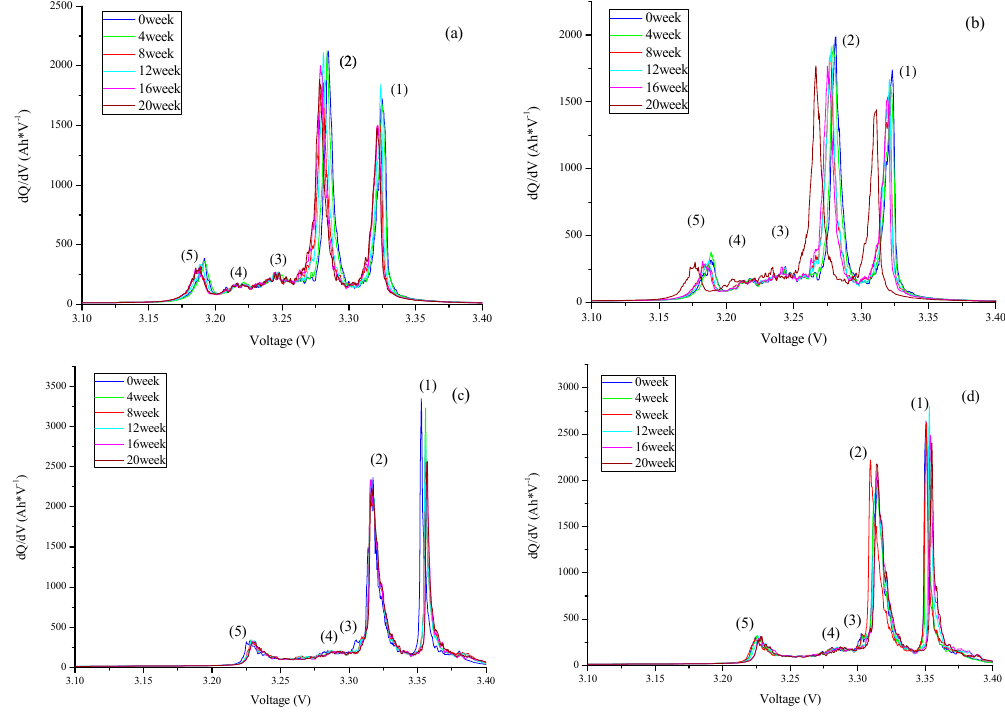
Figure 6. Discharge and charge incremental capacity (IC) curve of different weeks for two cells: ( a ) #1 cell for discharge; ( b ) #2 cell for discharge; ( c ) #1 cell for charge; and ( d ) #2 cell for charge.